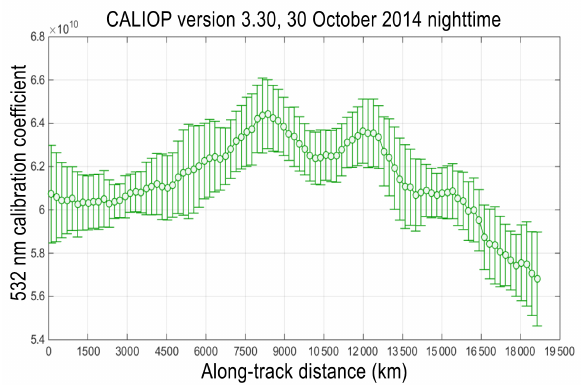
Figure 4. Mean 532nm calibration coefficients (km 3 srJ − 1 count) in V3 (computed at 30–34km) as a function of orbit along-track dis- tance computed for all nighttime data acquired on 30 October 2014. The peaks in the curve at ∼ 8250km and ∼ 12000km are the re- sult of aerosol contamination in the 30–34km calibration region. The marked drop-off beginning just after 15000km is attributed to thermal beam steering caused by warming as the satellite first en- ters the sunlit portion of the orbits. For nighttime, the orbit starts in the north, and the starting point of the along-track distance is at the day–night